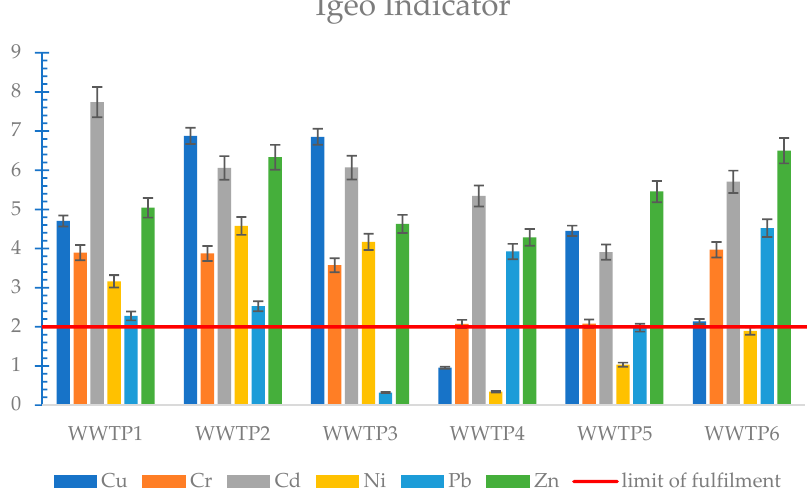
Figure 3. Igeo indicator of heavy metals in sewage sludge.